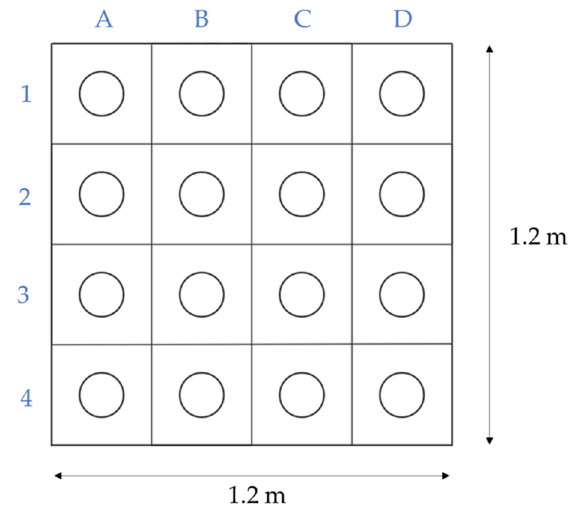
Figure 6. Code of the extracted